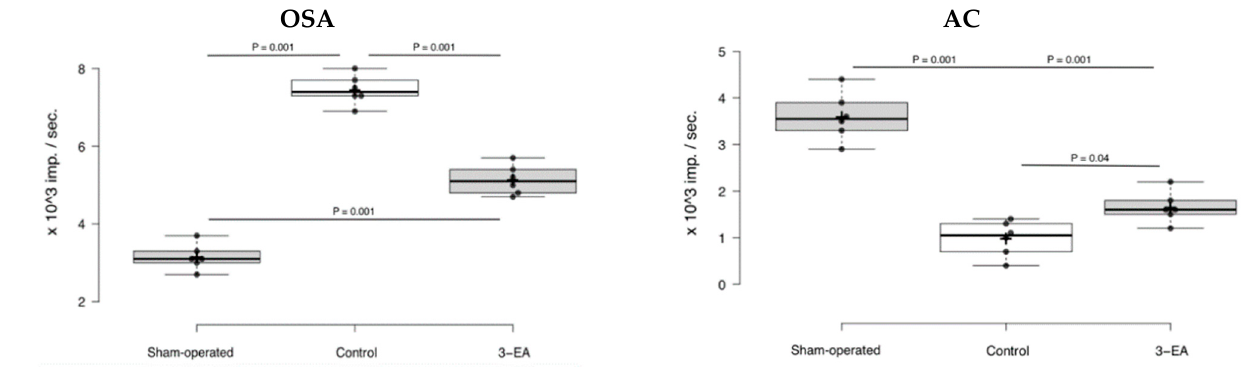
Figure 8. Oxidative stress activity ( OSA ) and antioxidant capacity ( AC ) of rats’ brain tissue in ischemic (for control and 3-EA groups) and anatomically related (for sham-operated group) areas; n = 6 in each group, data presented as boxplots with mean ± SD, and significance of differences was assessed by ANOVA and the Tukey’s test.